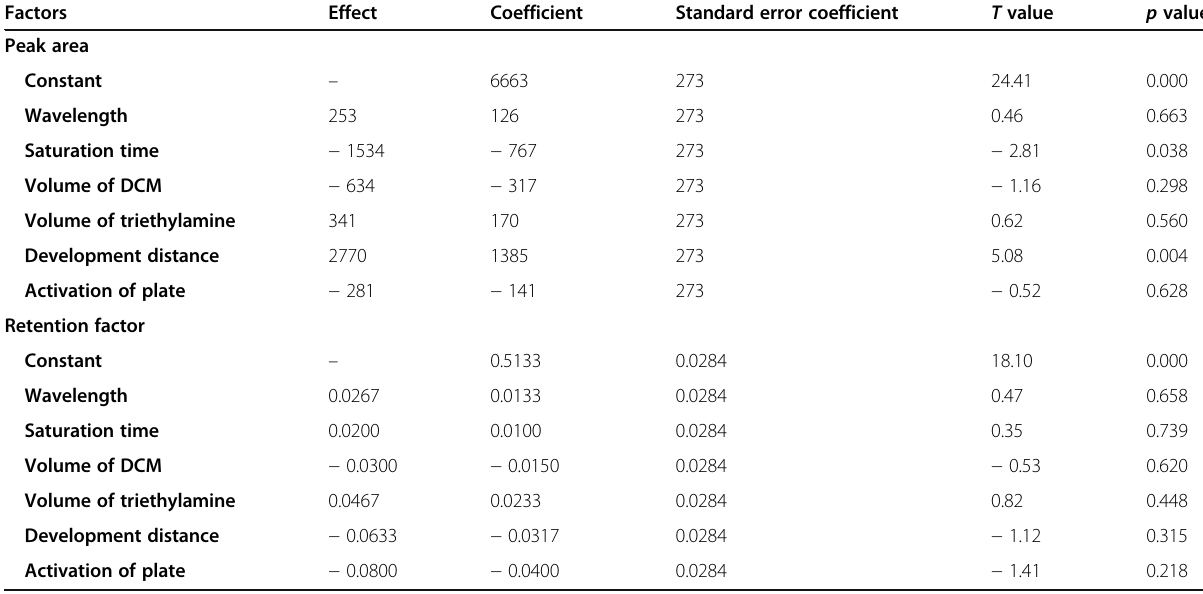
Table 4 Plackett-Burman design for statistical analysis and effect of independent variables on peak area and retention factor